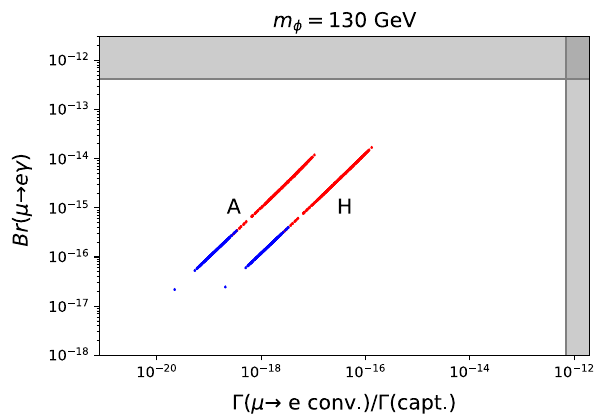
Fig. 5 The rates for μ → e γ and μ → e conversion for parameter spaceidentifiedbyneutrinodata.Here, m φ standsforthesmallestof m H and m A . Red (blue) points correspond to θ 23 being in the first (second) quadrant. The gray regions are experimentally